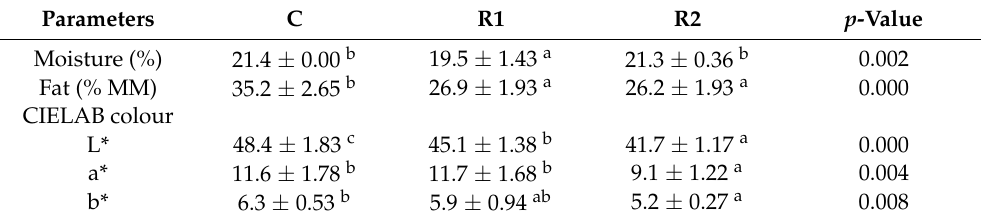
Table 2. Composition and instrumental colour of fuet sausages (means ±